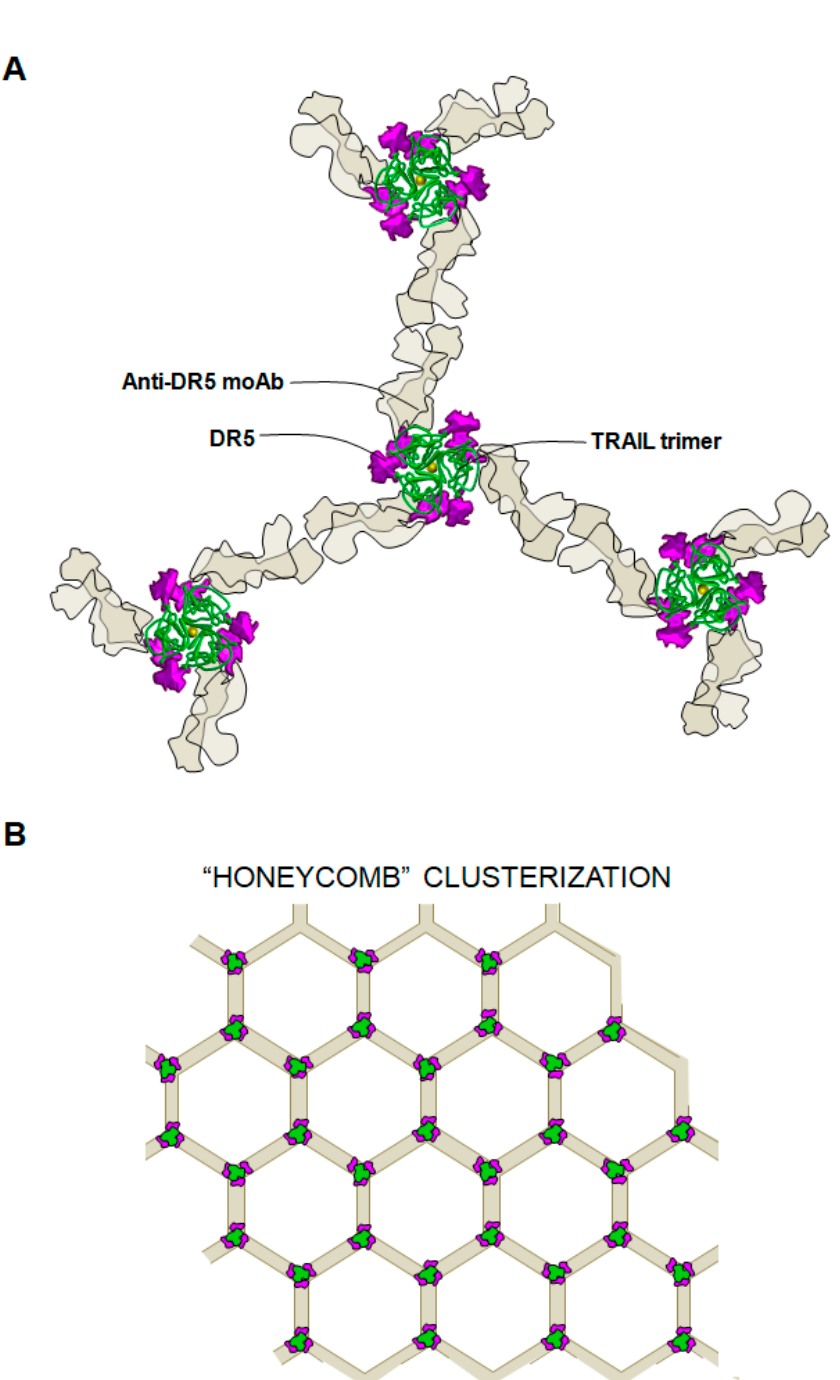
Figure 3. Proposed model of cooperation of TRAIL and anti-DR5 monoclonal antibody to promote receptor clustering. ( A ) View of three TRAIL-anti-DR5 monoclonal antibody ternary complexes (down view). ( B ) Proposed “honeycomb” model of higher order clustering induced by multiple ternary complexes. Green dots correspond to TRAIL bound to three DR5 receptors (purple). Light brown lines correspond to anti-DR5 monoclonal antibody Fab fragments expanding from DR5.